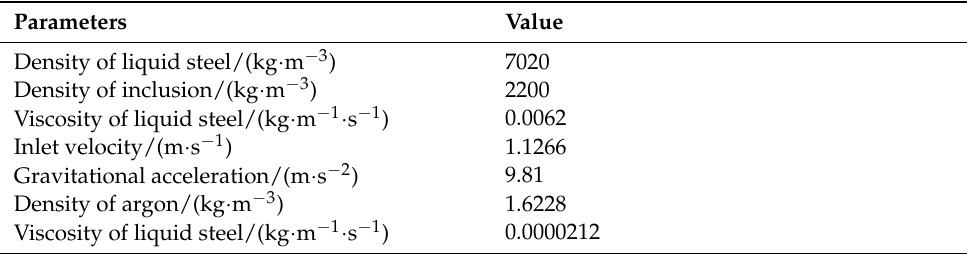
Table 1. Numerical simulation